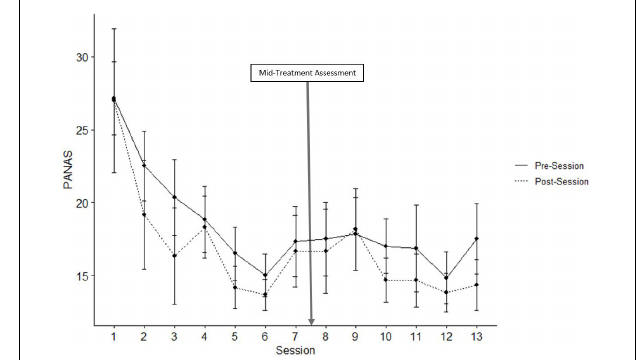
FIGURE 3 | Negative PANAS. Mean scores of negative item responses on the PANAS before and after all thirteen VR sessions. Error bars represent standard error of the